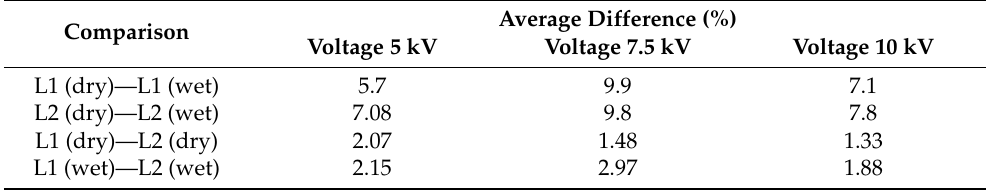
Figure 9. Leakage current frequency spectrum for the clean insulator and different pollution levels: ( a ) 5 kV; ( b ) 7.5 kV; ( c ) 10 kV. Table 6. The average difference between leakage current of both pollution levels and different conditions.